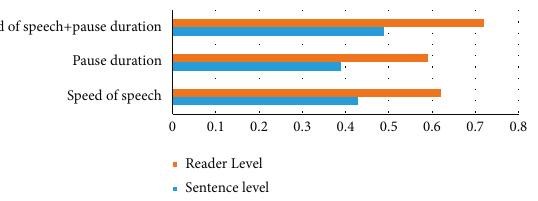
Figure 6: The result of pronunciation Table 4: The result of reading integrity.